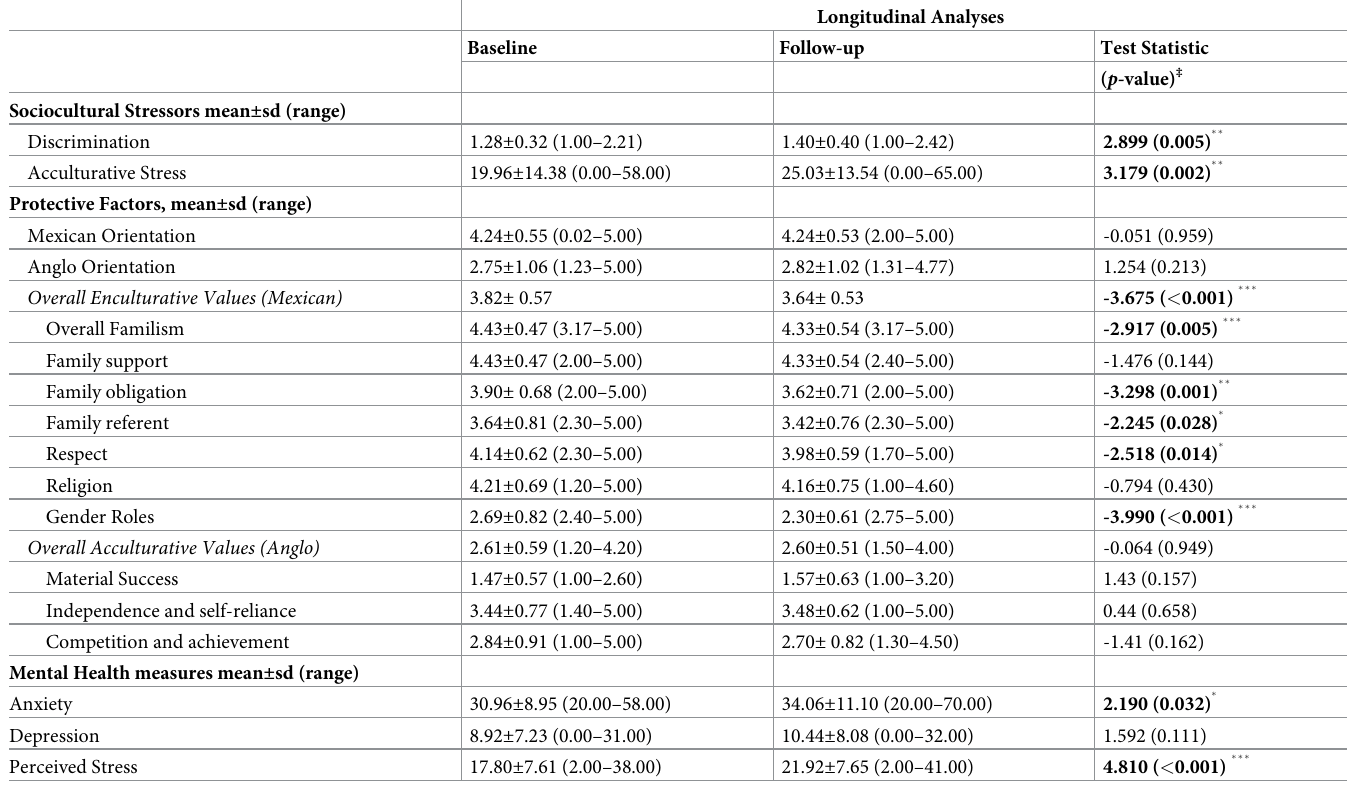
Table 3. Changes in sociocultural stressors, protective factors, and mental health measures for the border city from baseline to follow-up ( n s range